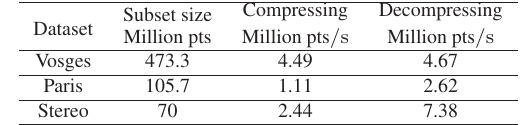
Table 5: Analysing compression and decompression computing cost.